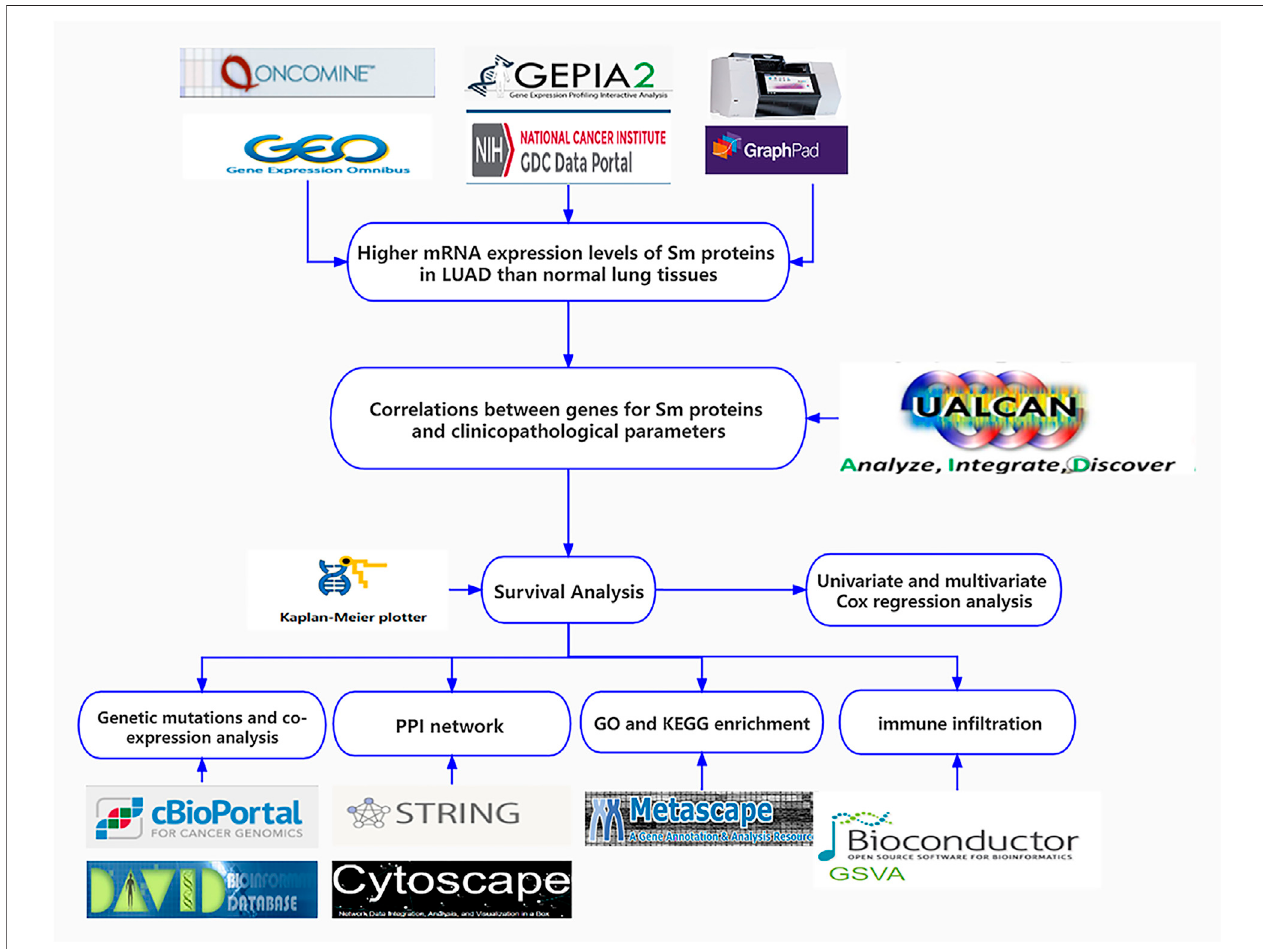
FIGURE 1 | Flow chart of the present